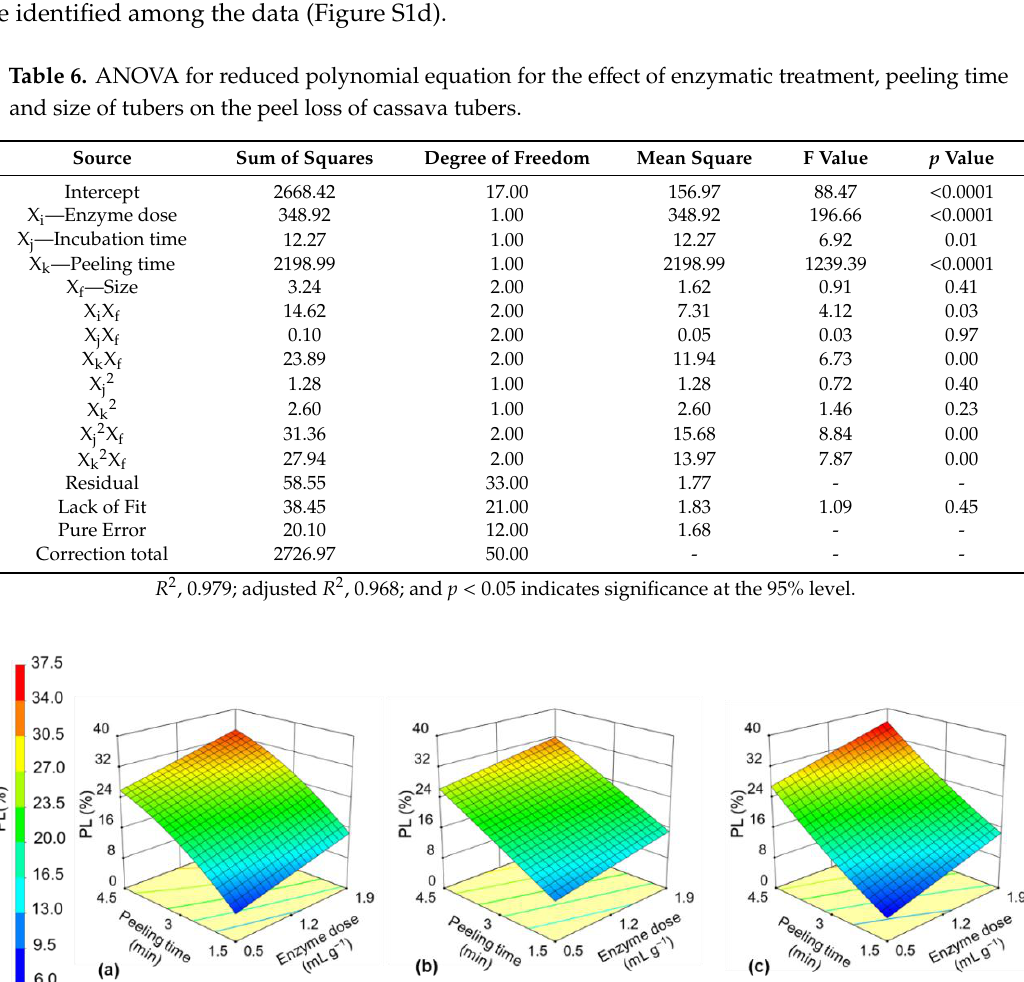
Table 7. Optimum operating conditions in terms of enzyme dose, incubation time and peeling time along with the measured (Exp) and predicted (Pred) values of the peeled surface area (PSA) and peel loss (PL) of small, medium and large size cassava tubers. Size Enzyme Dose (mL g −1 )